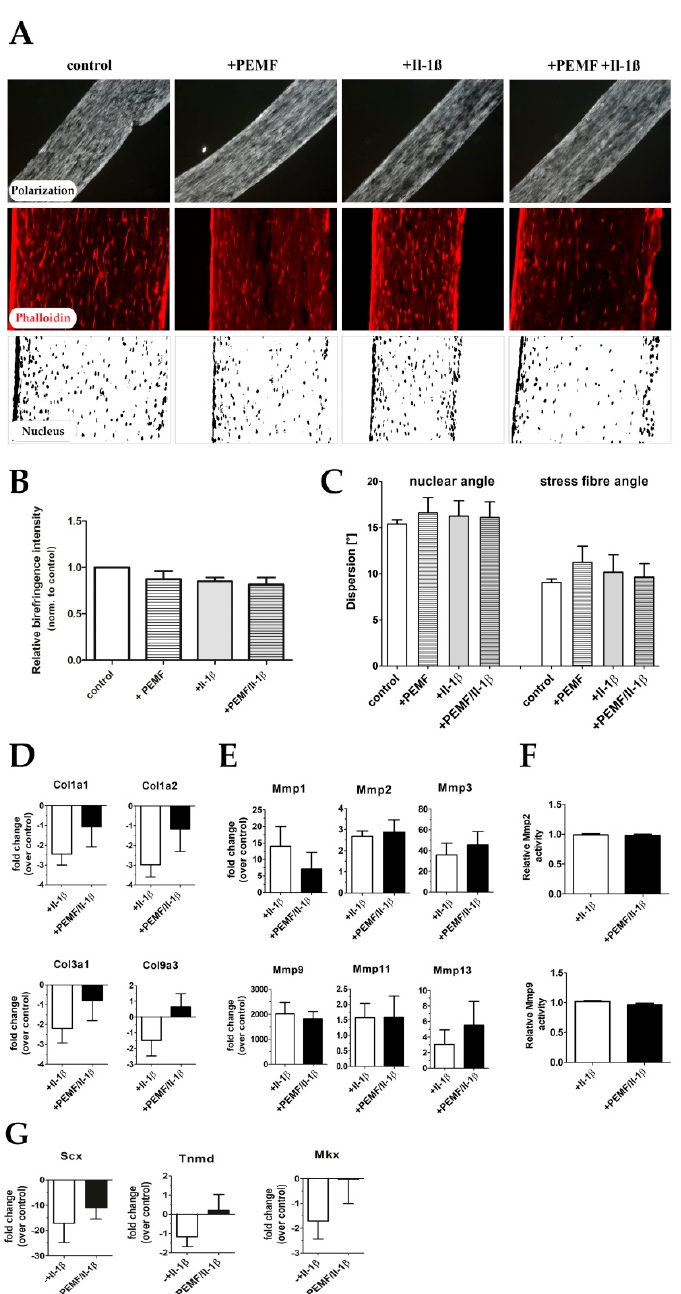
Figure 7. Extracellular matrix organization in tendon-like constructs before and after Il-1 β and / or PEMF treatment. ( A ) Polarization microscopic images, phalloidin staining, and nuclear stain (DAPI) of 3D tendon constructs. ( B ) Relative birefringence intensities as surrogate for collagen fiber organization ( n = 4). ( C ) Actin stress fiber angle and nuclear angle dispersion determined for the 4 treatment groups ( n = 4). ( D ) The expression of extracellular matrix genes Col1a1 , Col1a2 , Col3a1 and Col9a3 is shows up-regulation PEMF treatment in pro-inflammatory stimulated (+PEMF +Il-1 β ) samples although not statistically significant ( n = 9). ( E ) Under pro-inflammatory conditions the matrix metalloproteinases-1, -2, -3, -9, -11 and -13 show no significant changes in their expression after PEMF treatment ( n = 7). ( F ) Relative MMP2 and MMP9 activity in Il-1 β -stimulated constructs with and without PEMF exposure ( n = 10). ( G ) Expression of tendon related marker genes Scleraxis (Scx), Tenomodulin (Tnmd), and Mohawk (Mkx) is restored after PEMF treatment of pro-inflammatory primed tendon constructs ( n = 6).